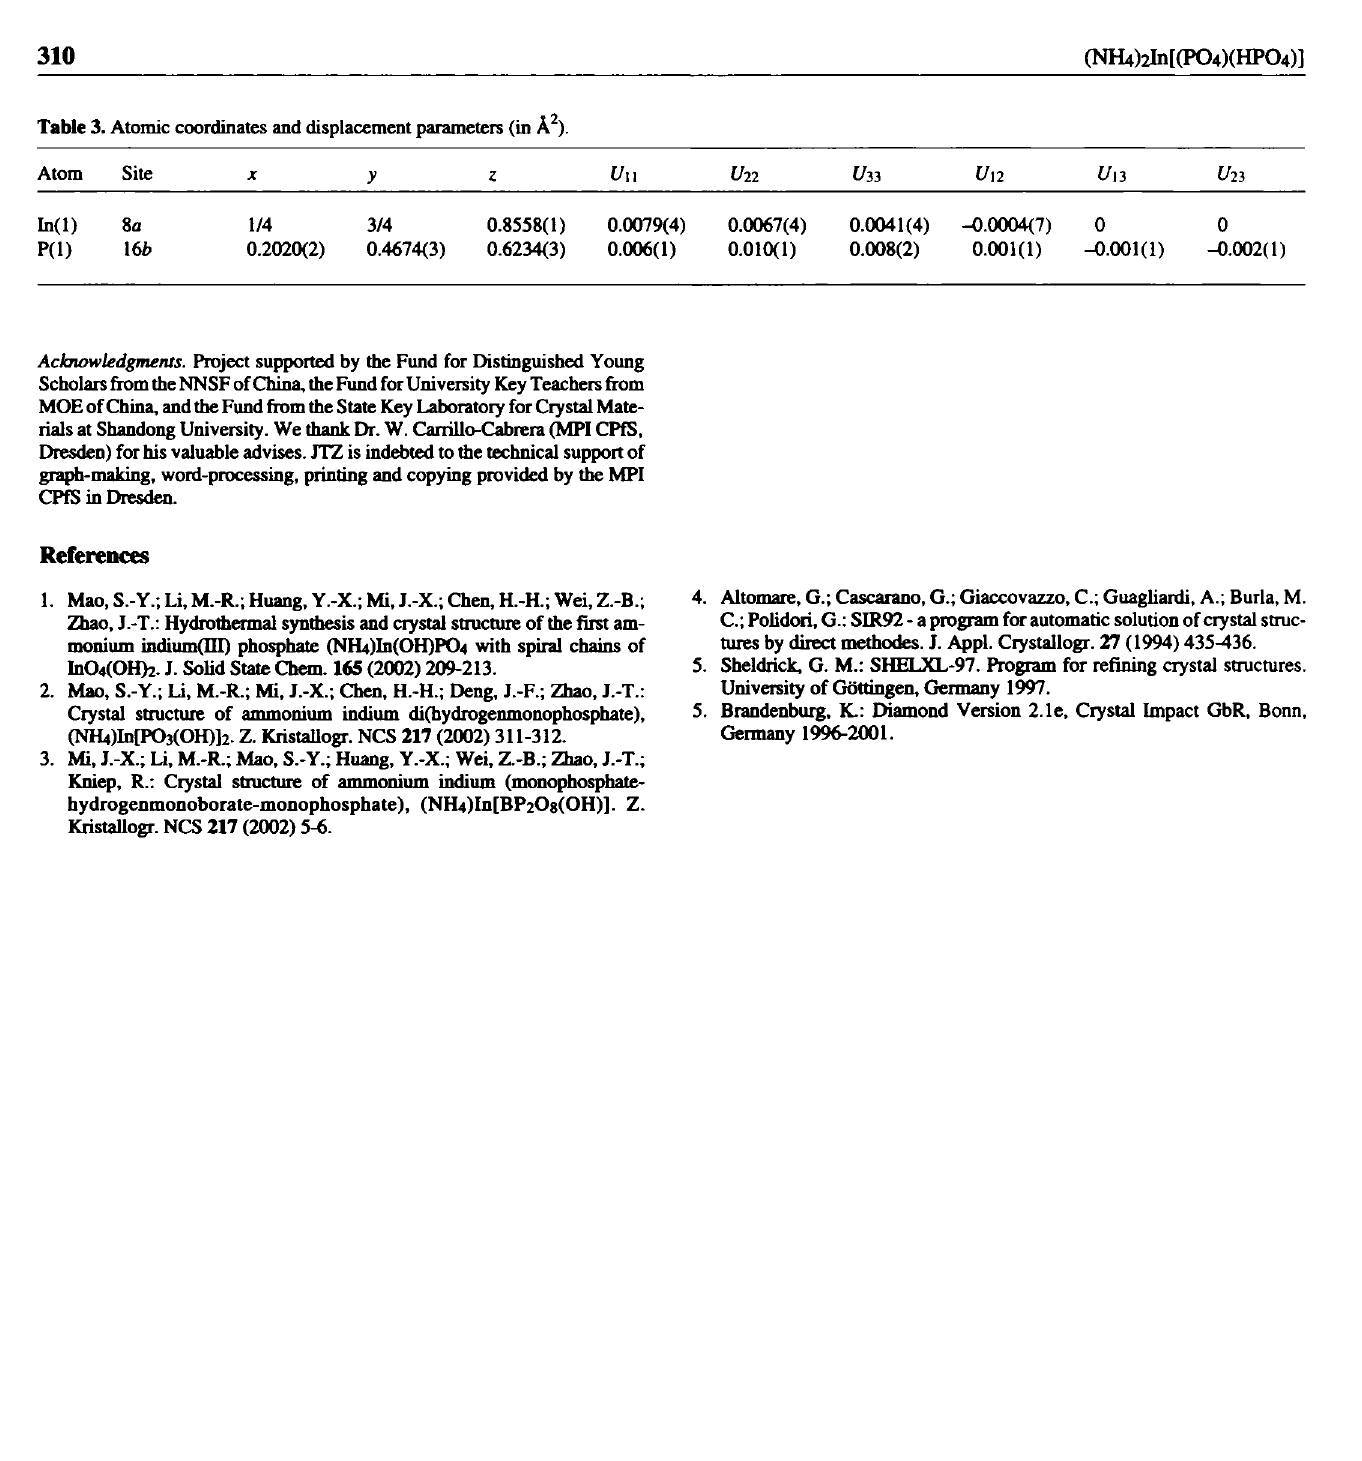
Table 3. Atomic coordinates and displacement parameters (in À 2